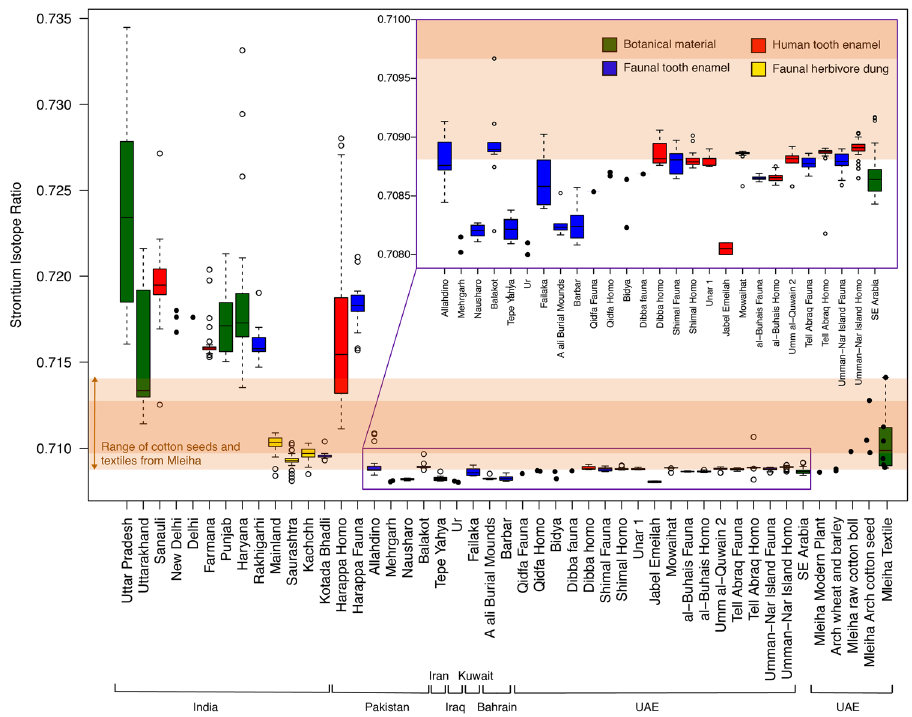
archaeological cotton seeds and textiles from Mleiha,